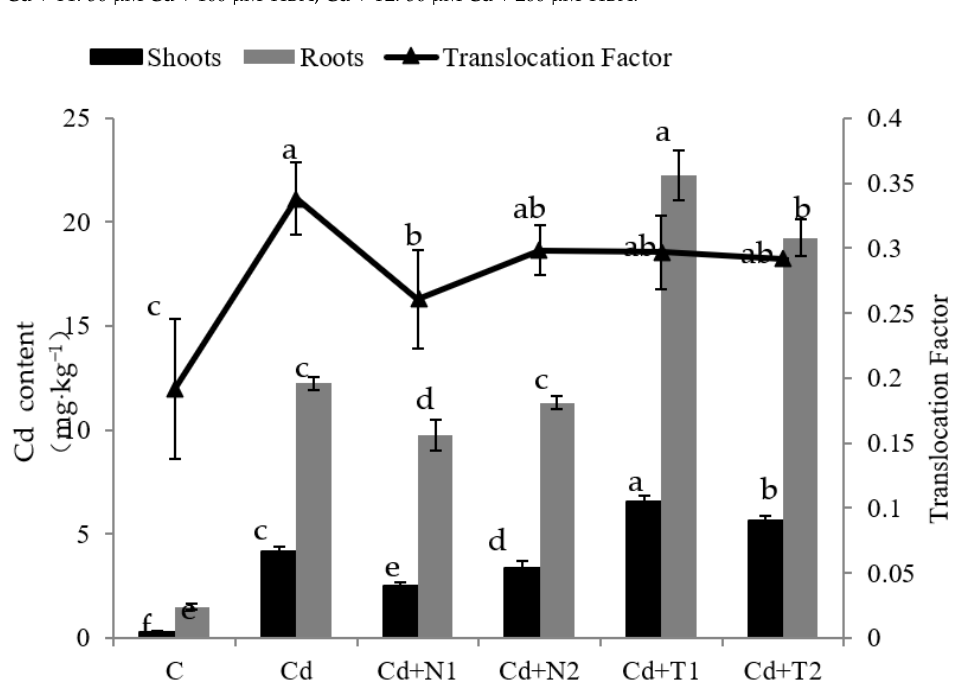
CAT Activity (Umin − 1 g − 1 FW)